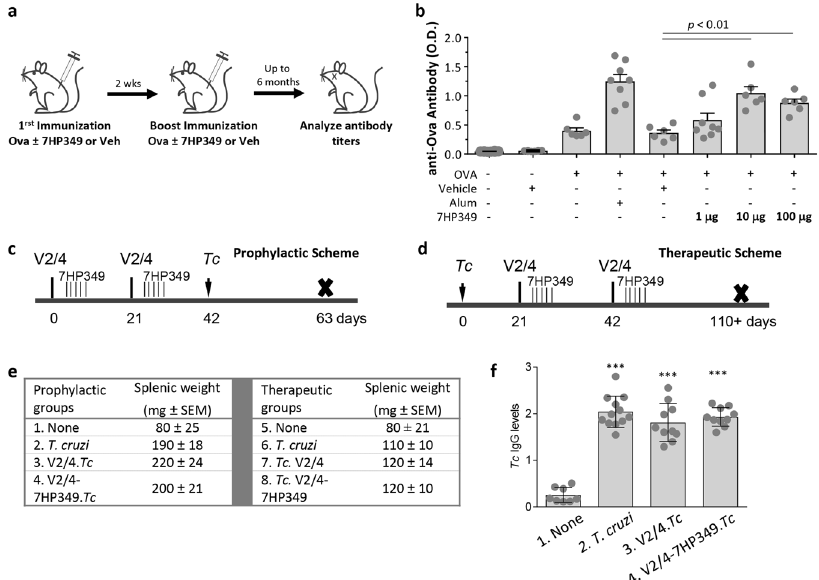
Fig. 2 Adjuvantation of humoral responses with 7HP349. a Ovalbumin (OVA) immunization and boost scheme. b Comparative OD values representing antibody titers generated at 2 months post-immunization and boost using OVA adjuvanted with 7HP349. C57BL/6 mice were immunized and boosted at 14 days. Sera were serially diluted and tested for antibody reactivity against OVA by ELISA. Relative OD values (450 nm) for each group are graphed at dilutions of 1:25,600. Mean values ± SEM are plotted ( n = 6 – 8 values per group). P values were determined by 1-way analysis of variance (ANOVA) with Tukey ’ s post-hoc test (comparison of multiple groups). c , d Chagas disease and immunization models. Mice (C57BL/6, females, 6 weeks age) were immunized with two doses of TcG2/TcG4-encoding DNA vaccine (V2/4) at 21-day intervals. 7HP349 was inoculated in 5 daily doses, beginning 1 day after DNA vaccine delivery. Challenge infection was carried out by intraperitoneal injection of 10,000 parasites per mouse. c Mice given the prophylactic vaccine were euthanized 21 days later corresponding to the acute infection phase. d Mice given the therapeutic vaccine were euthanized at 110 days post-infection corresponding to the chronic disease phase. e Splenic wet weight (mean value in mg ± SEM). f Serum levels of anti- T. cruzi antibodies in prophylactically immunized/ infected mice were monitored by an ELISA. Data are presented as mean ± SD and signi fi cance (non-infected vs. infected or vaccinated/ infected) is annotated as *** p < 0.001. P values in bar graphs ( b , f ) were determined by 1-way analysis of variance (ANOVA) with Tukey ’ s post- hoc test (comparison of multiple in the splenic percentages of CD4 + TN and CD4 + TN int subsets (Fig. 3c, d, blue bars) and an increase in the CD4 + TEM and CD4 + TCM subsets (Fig. 3e, g, blue bars). Moreover, frequencies of CD8 + TN and CD8 + TCM int were not changed after infection (Fig. 3h, k, blue bars), CD8 + TN int and CD8 + TCM subpopulations were decreased in all infected (vs. control) groups (Fig. 3i, l, blue bars ) , while CD8 + TEM subset (8.2 – 15.1-fold) expanded in infected mice (Fig. 3j, blue bars). Notably, maximal expansion of the CD8 + TEM subset was observed in V2/4-7HP349. Tc group (Fig. 3j, blue bars). The T cells pro fi le after in vitro stimulation with Tc antigenic lysate is shown in orange bars in Fig. 3. The splenic DN TEM and DN TCM subsets of infected mice were expanded upon 2nd antigenic stimulation, and maximal increase in DN TCM subset was noted in V2/4-7HP349. Tc group (Fig. 3a, b, compare blue and orange bars). The CD4 + TN subset was increased by >3-fold, CD4 + TN int and CD4 + TEM subsets were shrunk by 33 – 58.5%, and the CD4 + TCM subset exhibited non-signi fi cant changes in response to in vitro antigenic exposure in non-vaccinated/ infected and V2/4. Tc mice (Fig. 3c – g, compare blue and orange bars). In comparison, stable frequencies of CD4 + TN and CD4 + TEM subsets and an increase in the CD4 + TCM subset were noted in V2/4-7HP349. Tc mice after in vitro antigenic stimulation (Fig. 3c, e, g, compare blue and orange bars). Regarding CD8 + T cells, all infected mice exhibited a general decline in CD8 + TN, CD8 + TN int , and CD8 + TEM subsets after in vitro antigenic exposure (Fig. 3h – j) that indicates that CD8 + T cells likely apoptosed after primary activation. More of the CD8 + T cells exhibited TCM int (1.5 – 3.1-fold increase) phenotype all infected groups (Fig. 3k, l). These results suggest that (a)